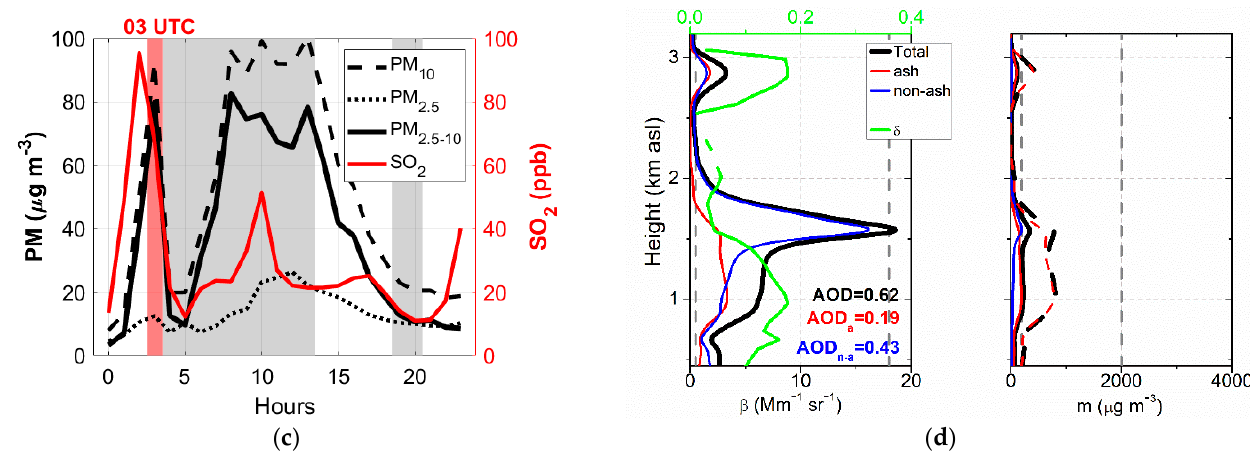
Figure 4. ( a ) Hourly PM and SO 2 concentrations on ( a ) 18 October and ( c ) 15 November. Grey areas indicate periods when the lidar signal was blocked. Profiles of total, ash, and non-ash particle backscatter coefficient and mass concentration on ( b ) 18 October at 03 UTC and ( d ) 15 November at 15 UTC. In the left plots, the particle depolarization ratio is also presented (upper axis), as well as the δ n − a and δ a values (grey, dash lines). In the right plot, the worst-case-scenario concentrations for total and ash mass concentration (Section 3.2) are represented by the dashed red and black curves.